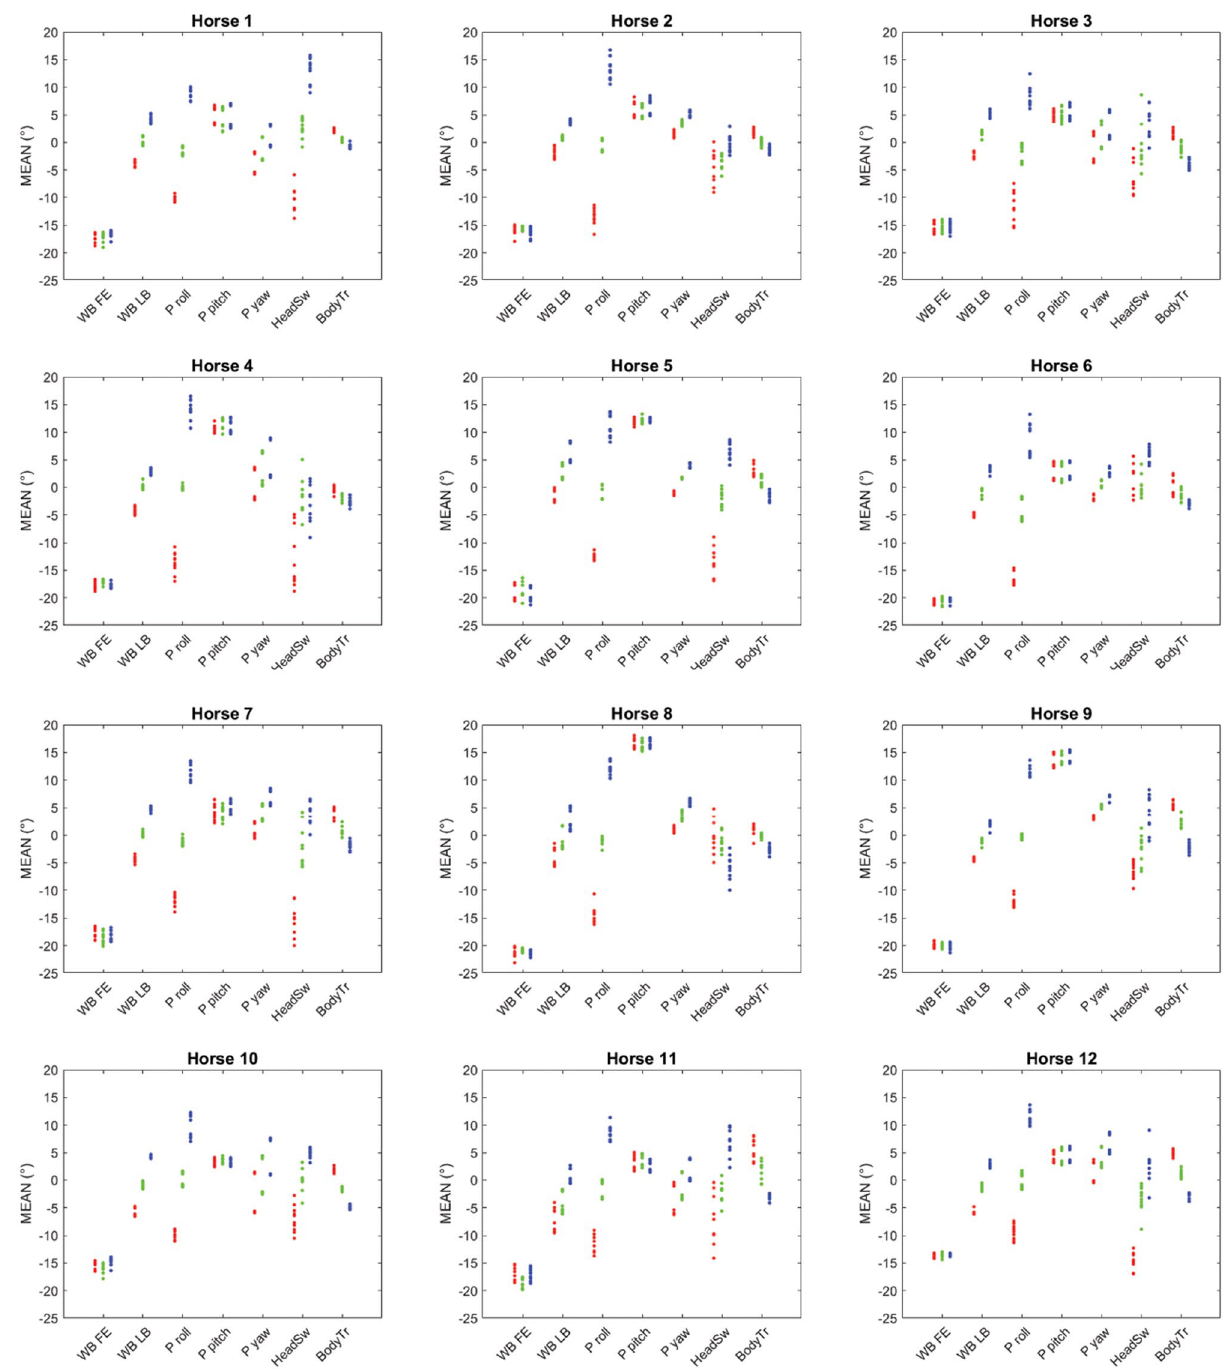
Figure 4. Measurement means for stride mean for whole back (WB) flexion–extension (FE) and lateral bending (LB), pelvis (P) roll, pitch and yaw, head swivel and body tracking. The plots contain data from 12 horses on three paths (red = left, blue = right, green = straight line), studied during two different days for five occasions each day (n = 355 measurements in